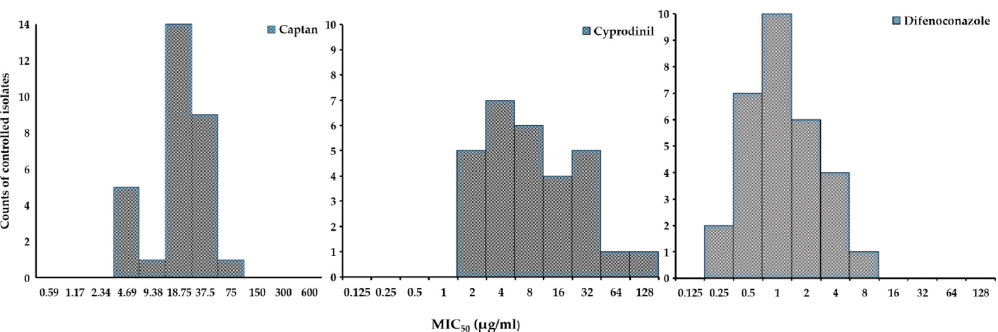
Figure 4. The frequencies of the MIC 50 values for the 30 A. pullulans isolates show non-normal distributions. The sensitivities of the 30 A. pullulans isolates to CPN, CYP, and DFN were determined in microbroth sensitivity assays. The minimum concentration inhibiting the growth of the yeasts by at least 50% (as determined by OD600 measurements; MIC 50 ) was calculated. The numbers of isolates with a particular MIC 50 value are plotted.